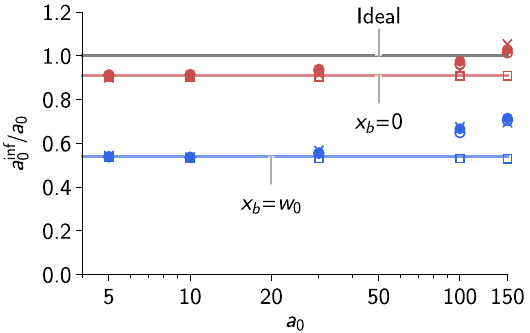
FIG. 5. The inferred a 0 as a fraction of the true a 0 , for the collision geometry shown in Fig. 4, for different values of a 0 : from simulations with quantum (filled circles), modified classical (open circles), classical (crosses), and no RR (squares); and as ¼ 0 (red) and x ¼ w predicted by Eq. (6) for x 0 b b